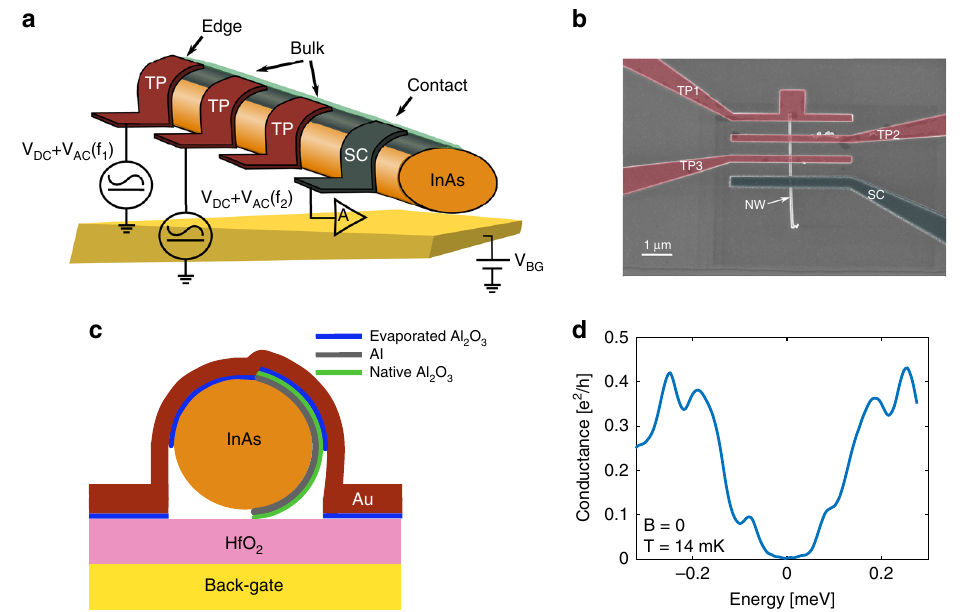
Fig. 1 The nanowire structure and its nonlinear conductance. a Schematic illustration of the nanowire and tunnel probes (TPs). A superconducting Al contact, connected to the epitaxial Al on the wire (both in gray) is grounded via a current ampli fi er. Several TPs are connected to the edge and bulk of the wire (red), used as local voltage sources, separately or simultaneously. Each TP is only connected to the wire, since the epitaxial Al is isolated by a thick native Al oxide. The chemical potential is controlled via a global back gate. b An SEM micrograph of a typical device with three TPs (red) and a grounded superconducting contact (gray). c Schematic side view of a TP region: the InAs wire (orange) was covered by an epitaxial layer of epitaxial Al (7-nm thick, gray, on the right), which is oxidized (oxide thickness is 3 nm, green). The wire is placed on top of a metallic back gate, which is covered by a 50 -nm-thick HfO 2 insulating layer. Each TP is made of a thin Al-oxide barrier (blue) and a metallic Ti/Au contact (red). d The typical differential conductance measured by the bulk TP shows a hard gap with Δ ind = 250 µ eV (at B = 0 and T = 14 mK)